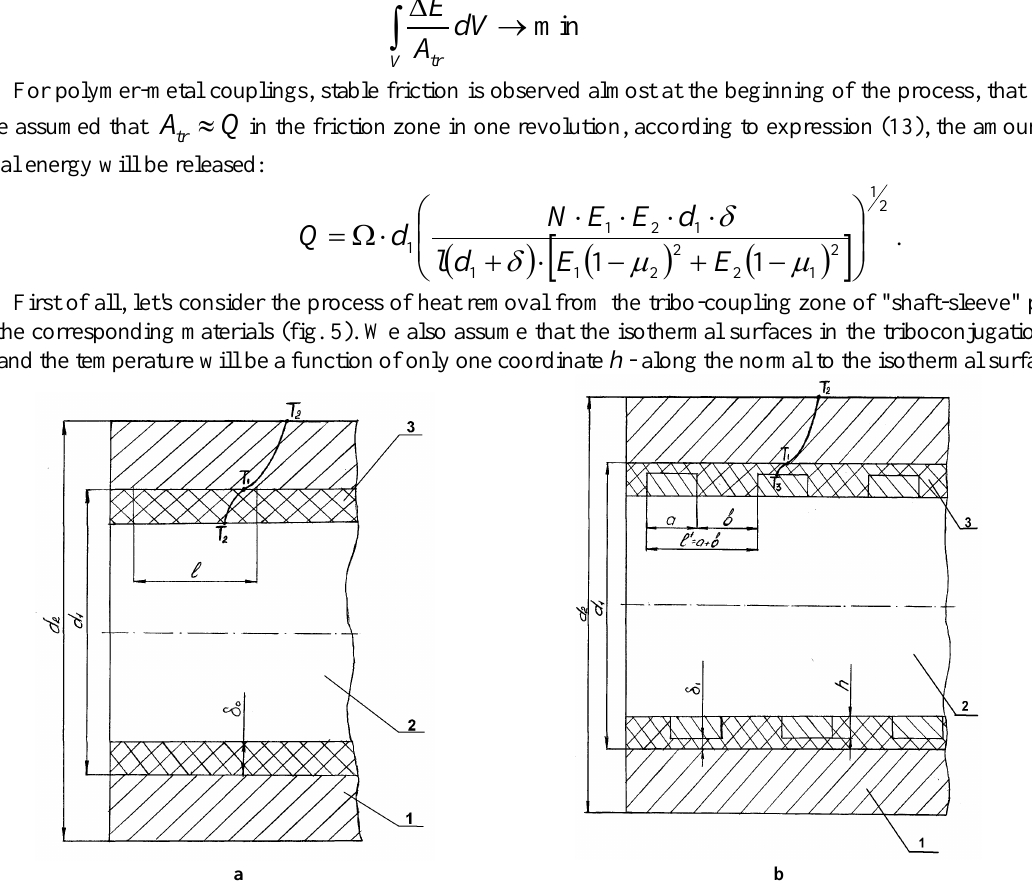
Fig. 5. Scheme of removal of thermal energy from the friction zone for PC (a) and PCC (b): 1 - sleeve; 2 - shaft; 3 –